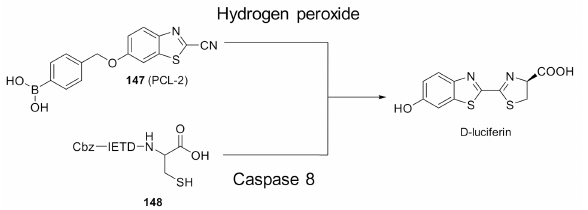
Figure 9. Chemical structures of bioluminescence probe for dual analytes.